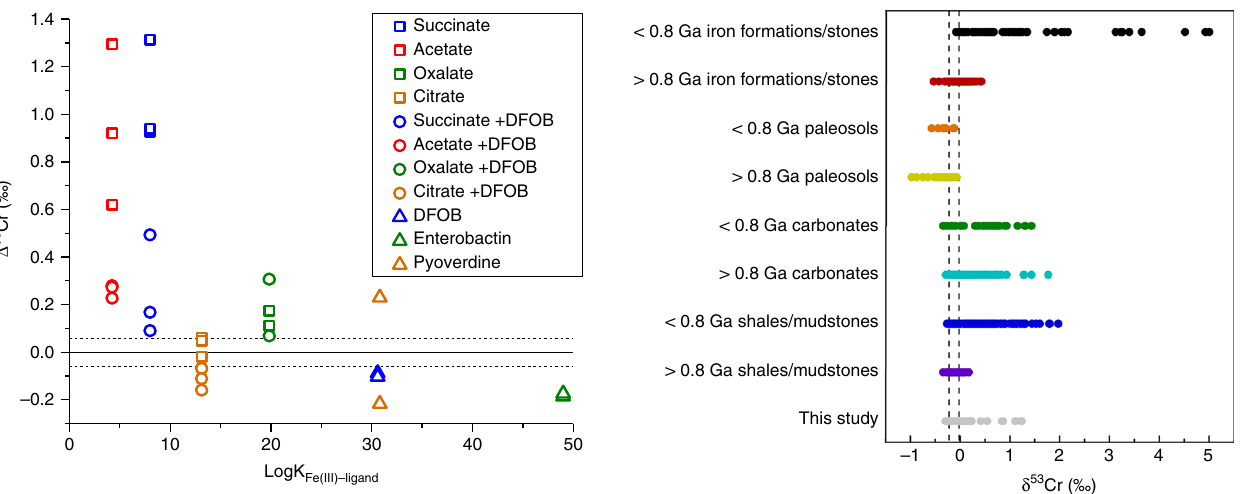
Fig. 6 Cr signatures from this study compared to fi eld data. Redox- independent Cr isotope signatures observed in this study compared with previously observed δ 53 Cr ranges from various archives: iron formations/ stones 1,3,4,56 , paleosols 3,57 , carbonates 14,56 , and shales/ mudstones 2,4,5,9,55 . The dashed lines delineate the δ 53 Cr ranges of igneous rocks (mainly basalts and granites)